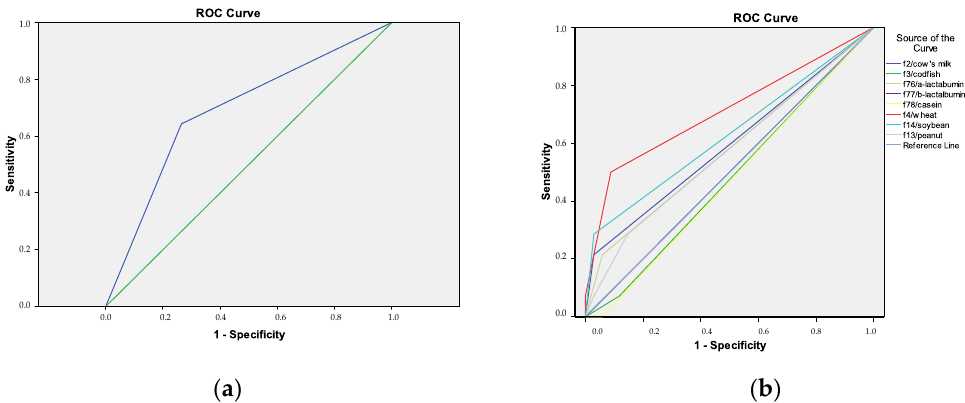
Figure 7. ROC curve for assessment of the specificity and sensitivity of EUROIMMUN food (as a panel positive/negative) to ImmunoCAP fx5 ( a ), ROC curve for evaluation of the specificity and sensitivity of EUROIMMUN food (distinct sIgE) to ImmunoCAP fx5 ( b ). When combining milk allergens (f2, f76, f77, f 78) in one variable, the predictive value